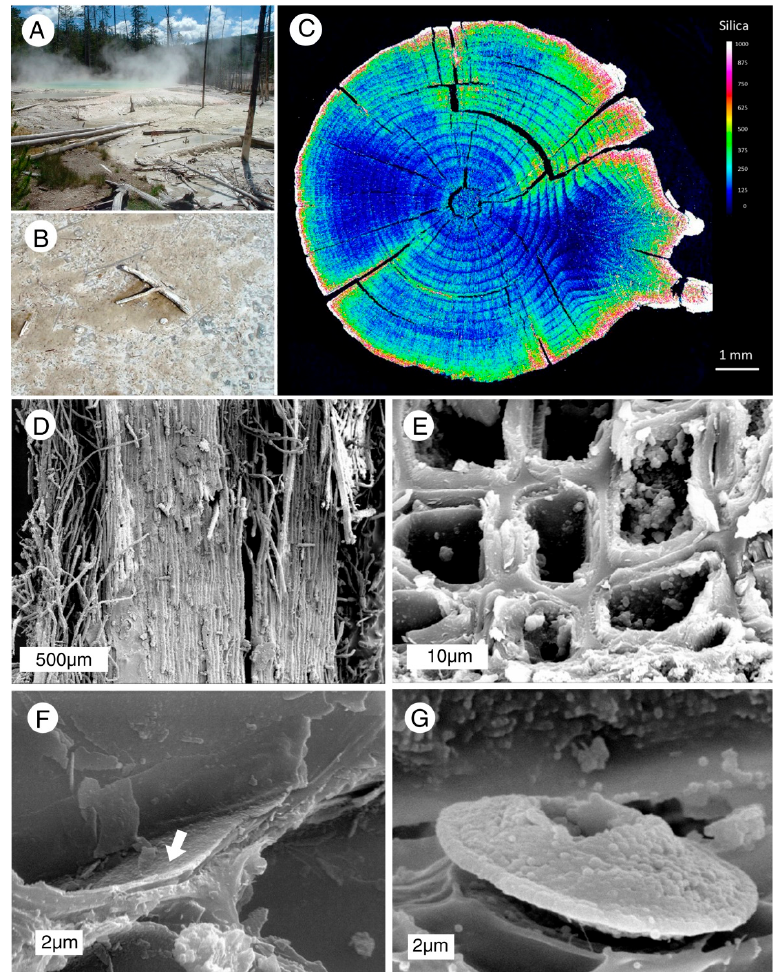
Figure 12. Incipient permineralization of modern Pinus contorta (Lodgepole Pine) wood can be observed at hot springs in Yellowstone Park, WY, USA. ( A , B ) silica encrusted woody debris on hot spring sinter apron; ( C ) Distribution of silica as mapped by X-ray microanalysis of transverse specimen. Warm, bright colors represent areas of elevated silica. Incipient silcification has occurred near exterior surfaces and along fractures [23]; ( D ) Radial orientation, showing cells encrusted with amorphous silica (opal-A); ( E ) Transverse view, tracheids showing multilayered unmineralized cell walls, with opal-A precipitated on interior surfaces; ( F ) High magnification shows thin silica zone (arrow) as an interlayer within tracheid cell walls; ( G ) Opal-A lepispheres encrust a pit aperture plate.